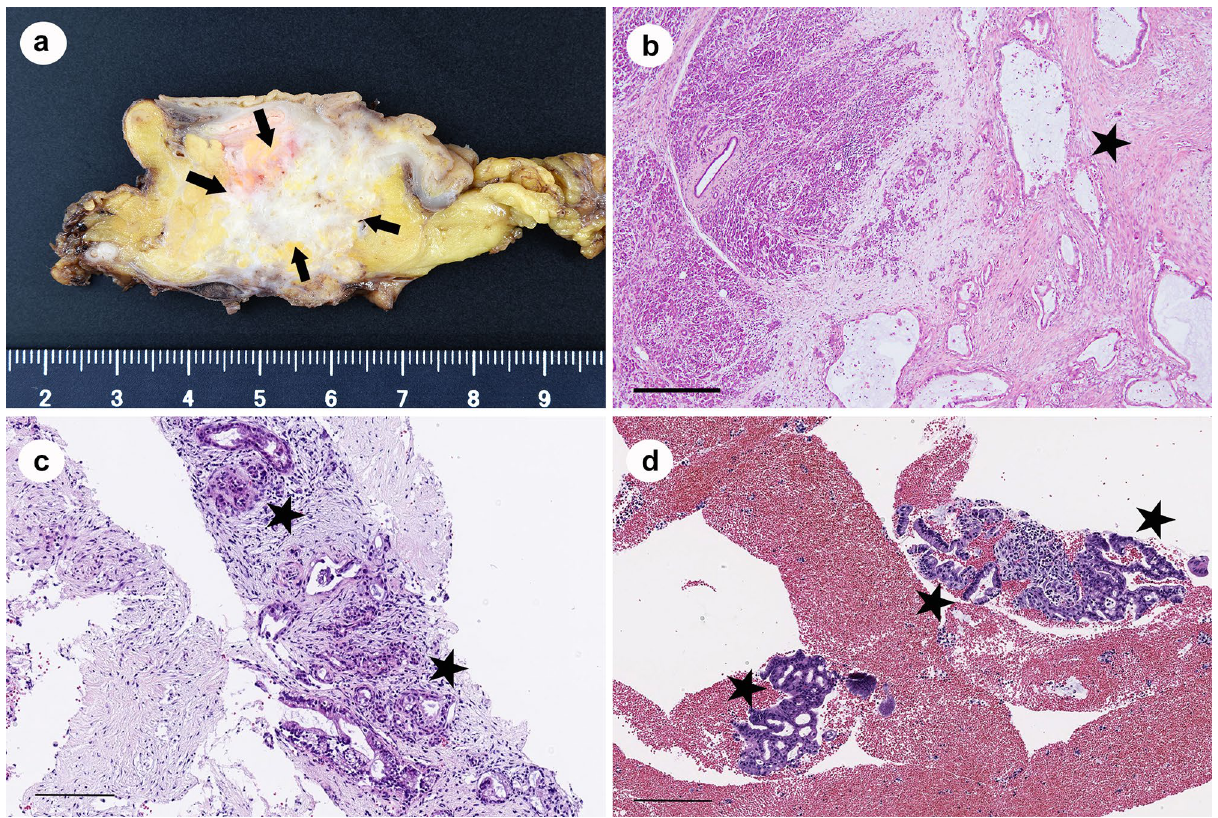
Figure 1. Histology of pancreatic ductal adenocarcinoma (PDAC). A representative resected PDAC in white color and showed an invasive growth pattern ( a ) Histologically, tumor cells with distinct glandular formation were infiltrating and proliferating within abundant stroma ( b ) The representative EUS-FNB specimen consists of the IDC ( c ) and ICC ( d ) foci within the blood or fibrin component. Arrows ( a ): tumor; stars ( b – d ): pancreatic ductal adenocarcinoma. Scale bars: 500 μm ( b ), 200 μm ( c , d